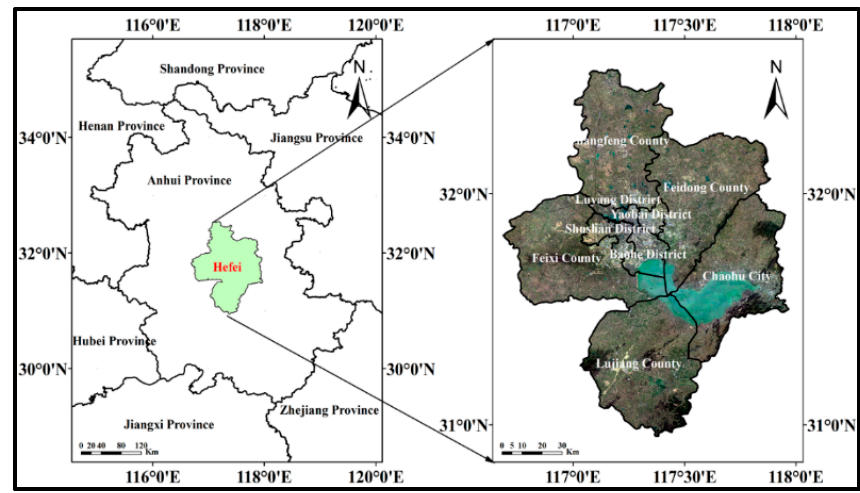
Figure 1. Spatial position of the study area.